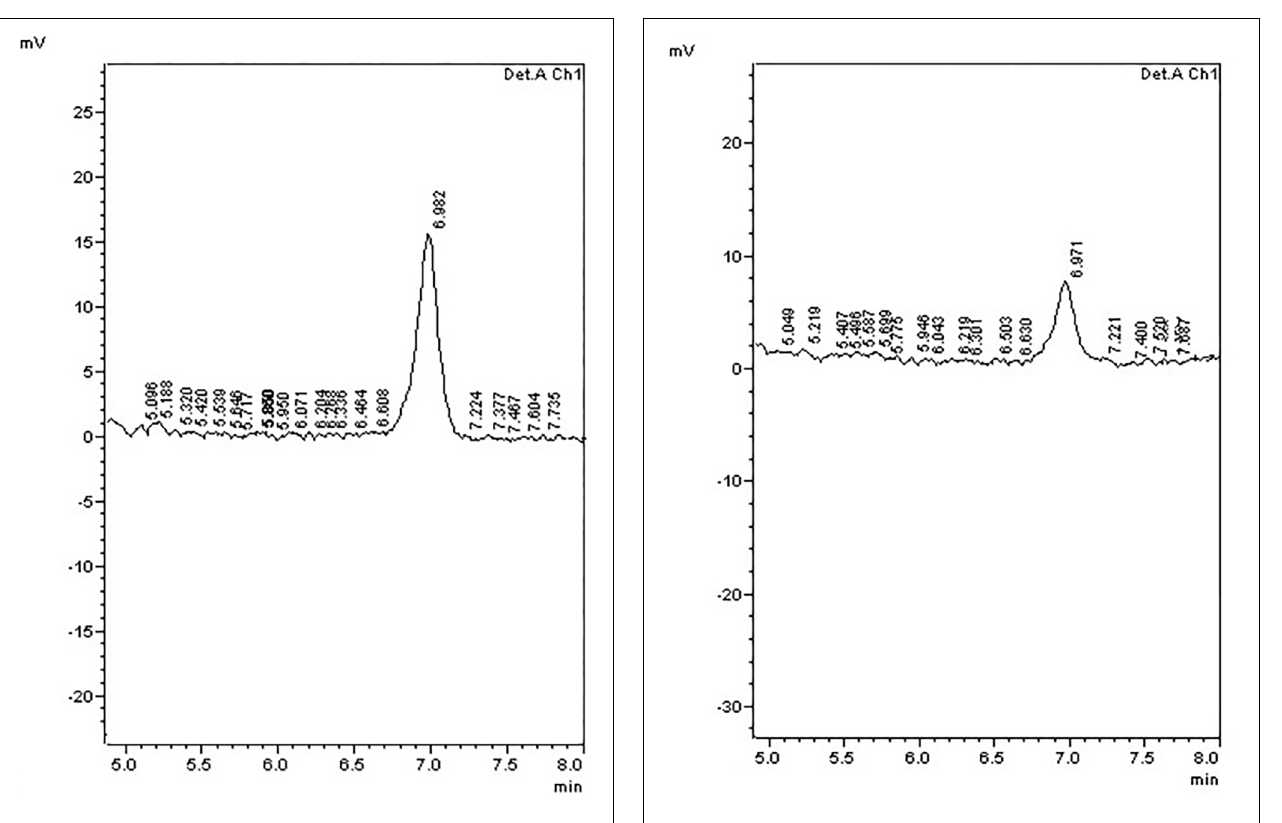
FIGURE 7 | HPLC phytic acid peaks of seed extracts from transgenic line